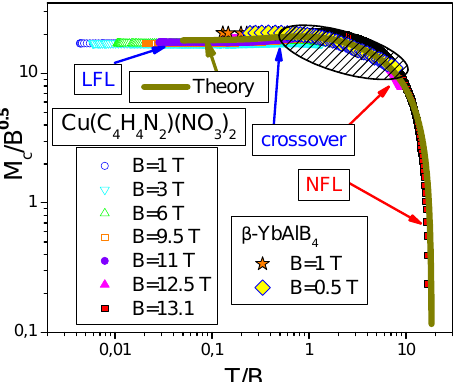
Figure 14. The scaling dependence of magnetization normalized to maximal values ( M c / B 1/2 ) N M , B = B s B ) on ( T / B ) N for CuPzN and β ( M c = M s YbAlB 4 . The experimental data are − − − taken from [25,31]. The magnetic fields B (in T) are shown in the legends. The typical LFL and NFL behavior are shown by both the arrows and the straight lines, the crossover is displayed by the arrow. The theory is represented by the solid green curve